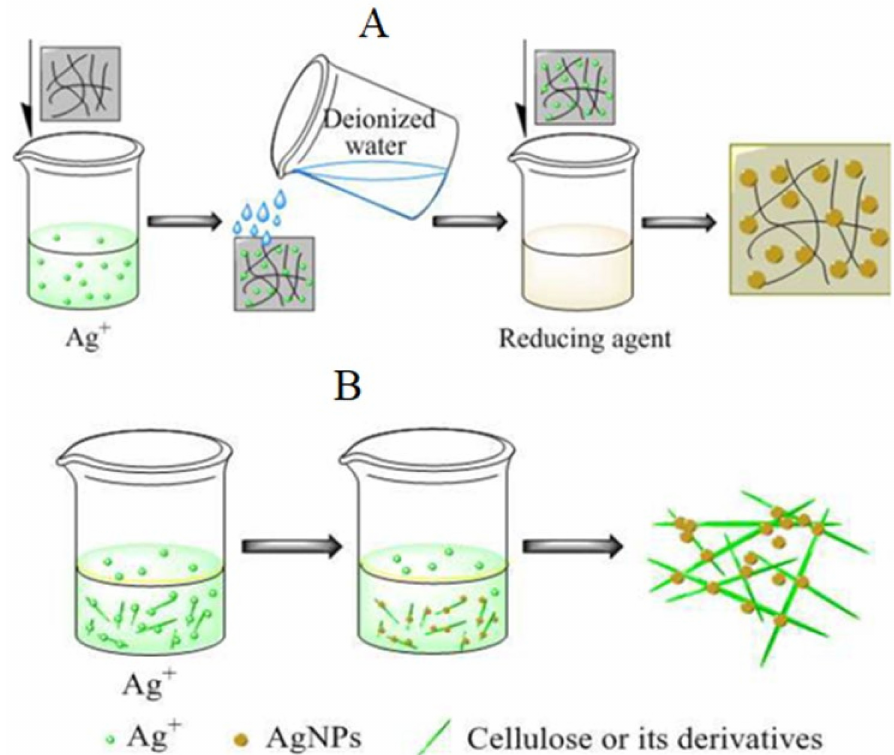
Figure 1. Chemical reduction methods of (AgNPs–cellulose composites). ( A ) Cellulosic materials act as both a matrix and a reducing agent; ( B ) cellulosic materials serve as a matrix